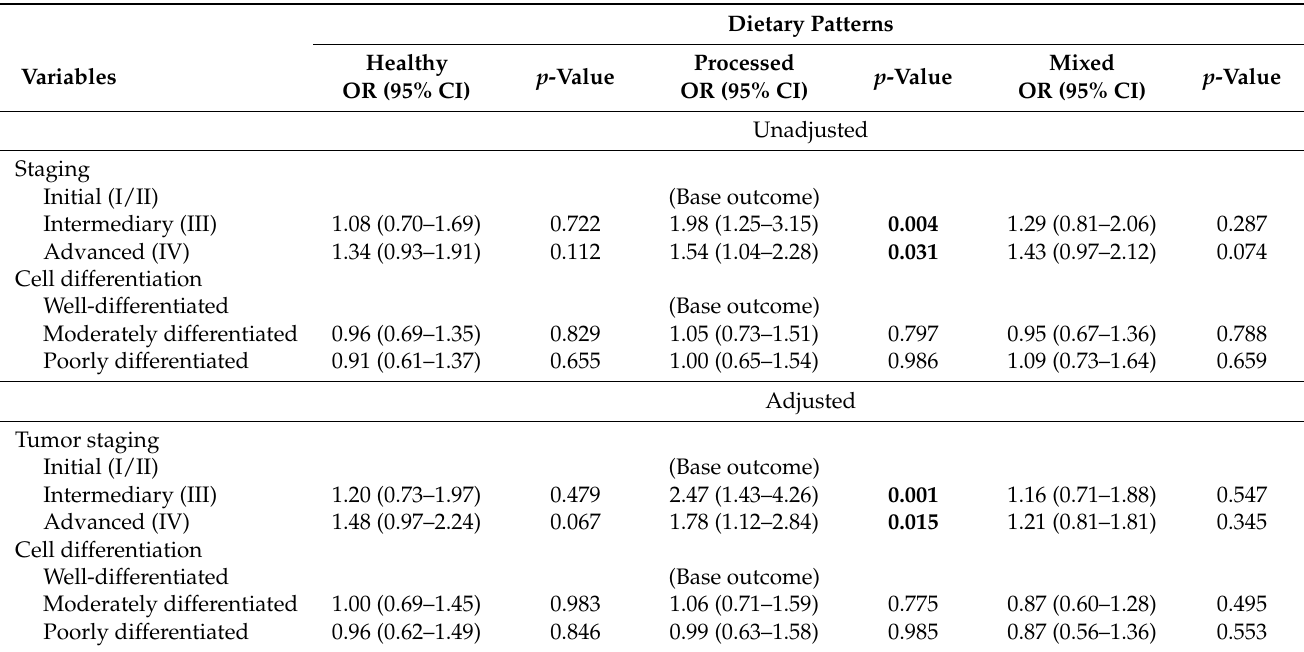
Table 2. Multinomial logistic regression and 95% confidence intervals (95% CI) for cell staging and differentiation and dietary patterns in pre-treatment HNSCC